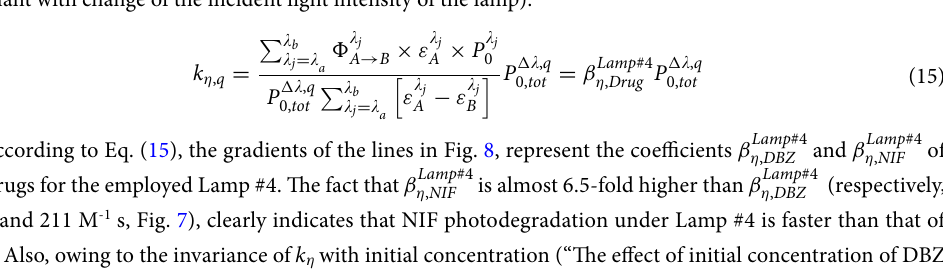
–5 M, respectively) at room